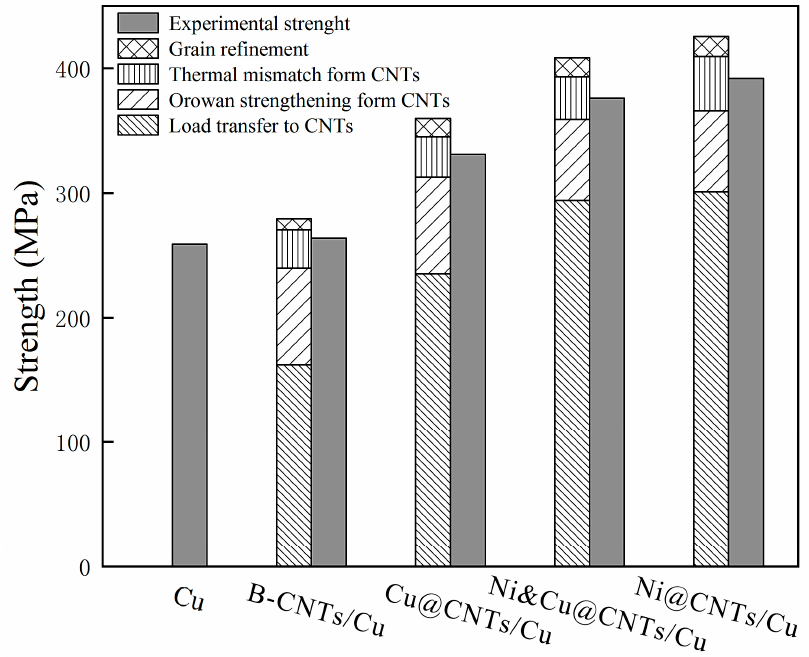
Figure 10. Theoretical and experimental results of the contribution of reinforcing mechanisms to tensile strength.